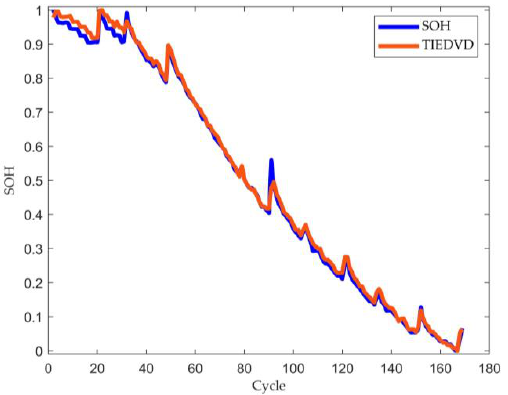
Figure 9. Qualitative analysis of SOH and TIEDVD.